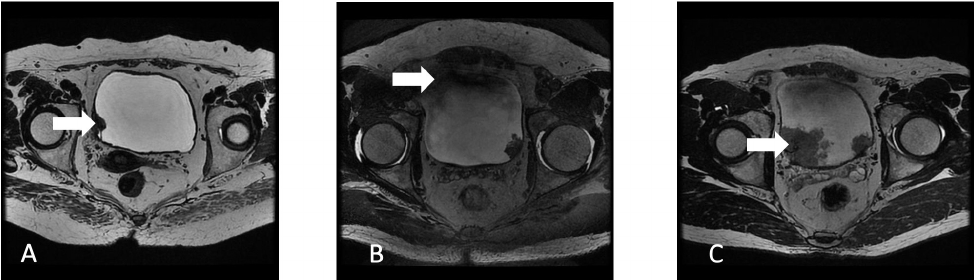
Figure 1. Challenges in bladder cancer segmentation are shown by the arrows: ( A ) tiny tumor area, ( B ) intensity of inhomogeneity and weak tumor boundaries, and ( C ) discrete tumor